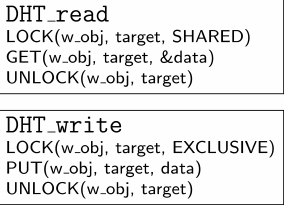
Figure 7. The hash value is used to determine the address of the corresponding bucket. Since collisions are possible, several possible addresses are derived from the hash value, and they are tested one after